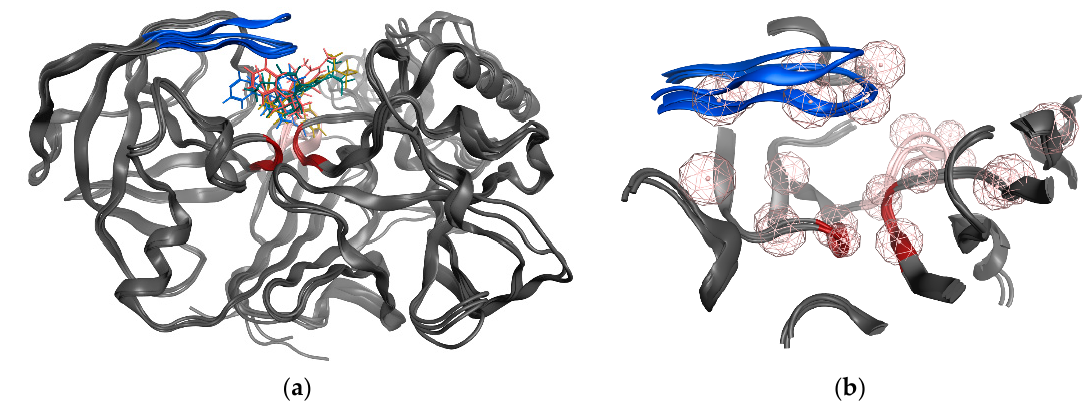
Figure 3. ( a ) Superposition of the four BACE1 complexes for generating common pharmacophoric features based on the interactions observed in the crystal structures. ( b ) Twenty-three excluded volume ( ExcV ) (light rosy spheres) are present in all structure-based (SB) models. The colors red, blue and light pink represent the catalytic motif, the flap region, and the 10s loop of the BACE1 protein, respectively. Table 1. Representation of SB pharmacophoric hypotheses and their inter-feature distances. Cyan sphere indicates the feature hydrogen bond acceptor ( HBA ); dark blue sphere represents hydrogen bond acceptor and metal ligation ( HBA&ML ); magenta sphere shows hydrogen bond donor and cation ( HBD&Cat ); red sphere represents hydrogen bond donor ( HBD ); dark magenta color represents